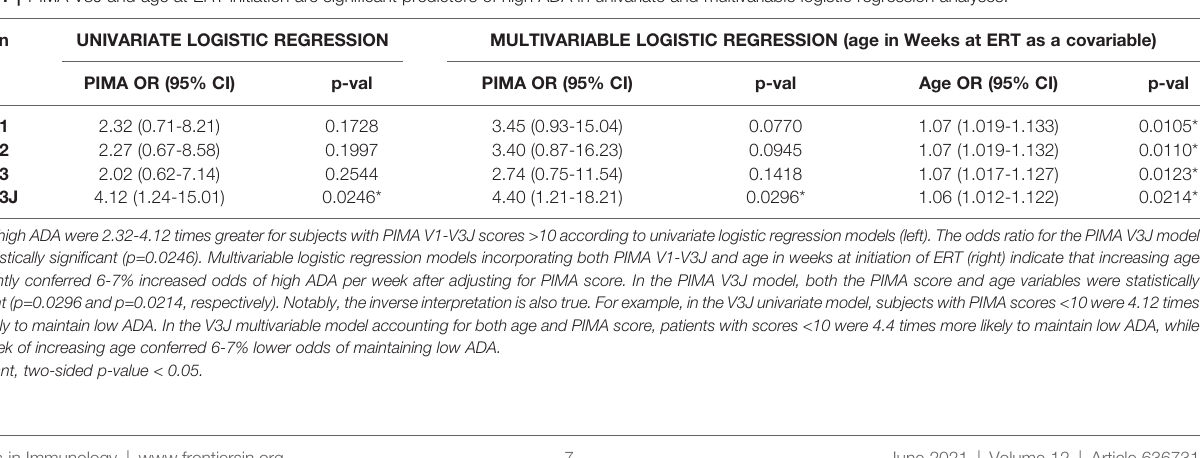
TABLE 1 | PIMA V3J and age at ERT initiation are signi fi cant predictors of high ADA in univariate and multivariable logistic regression